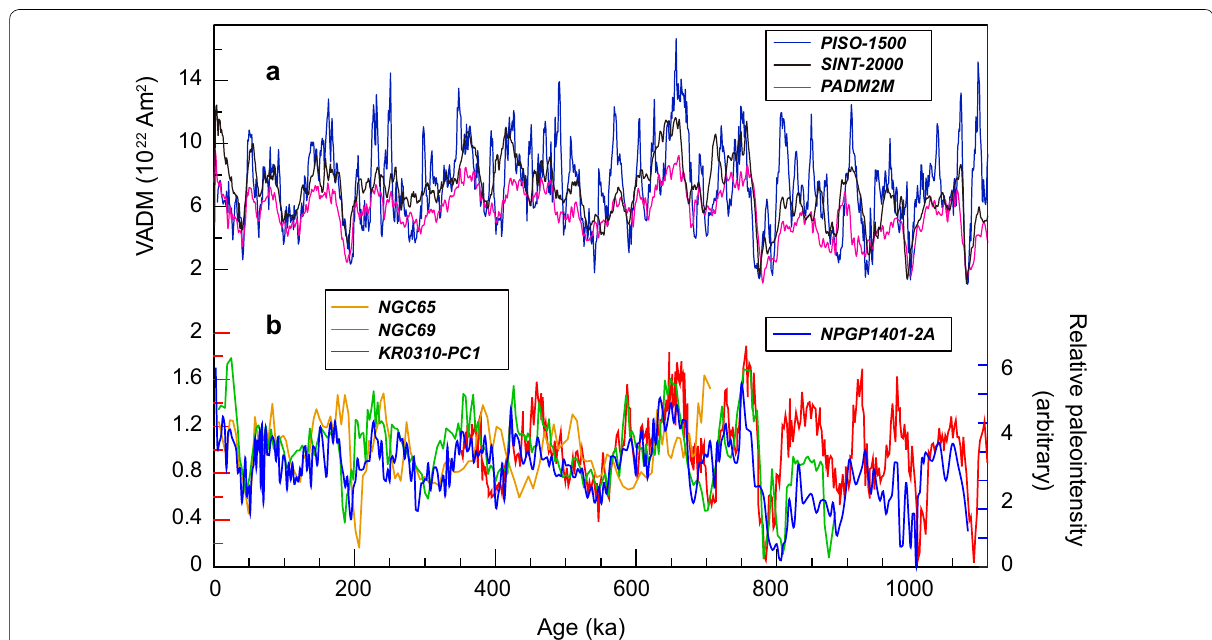
Fig. 9 Comparison between global RPI stacks (upper) and local RPI records from the North Pacific (lower). The global stacks are PISO-1500 (dark blue), SINT-2000 (black) of Valet et al. (2005), and PADM2M (magenta) of Ziegler et al. (2011). The local records are NGC65 (orange) and NGC69 (green) of Yamazaki (1999) and KR0310-PC1 (red) of Yamazaki and Kanamatsu (2007). The record of the studied core NPGP1401-2A is shown in